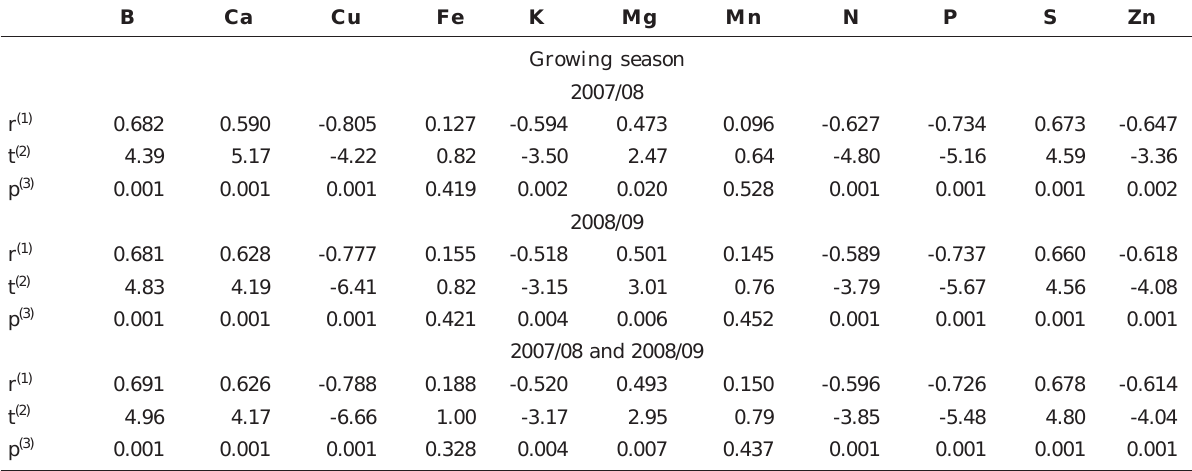
Table 5. Correlation of soybean seed oil content and DRIS values obtained in two consecutive growing seasons and for the combined set of it in samples collected from farm fields in the Plateau Region of Rio Grande do